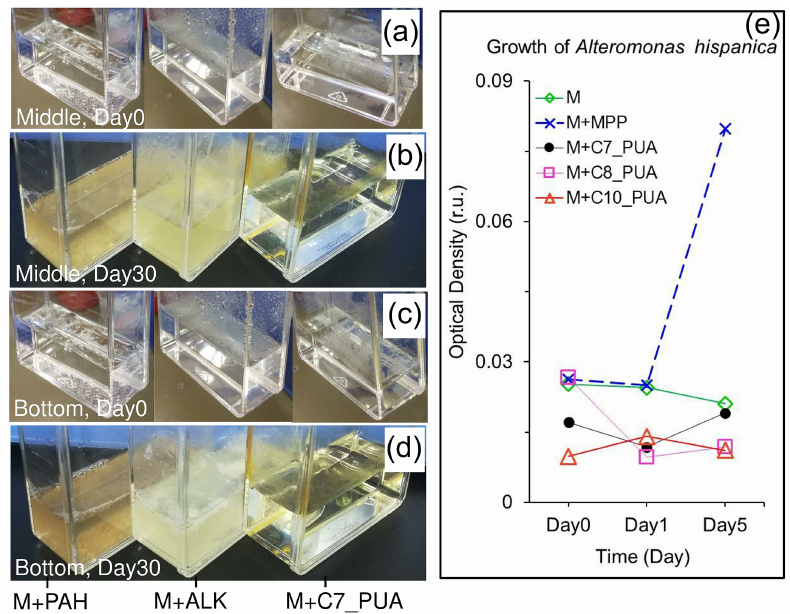
Figure 9. Carbon-source test of PUAs with cell culture of particle-attached bacteria inoculated from the low-oxygen waters of station Y1 including the initial conditions (day 0) at the beginning of the experiments as well as results after 30d of incubations (day 30) for (a, b) the middle and (c, d) the bottom waters, respectively. Bottles from left to right are the mediums (M) with the additions of polycyclic aromatic hydrocarbons (M + PAH, 200ppm), alkanes (M + ALK, 0.25gL − 1 ), and heptadienal (M + C7_PUA, 0.2mmolL − 1 ); note that a change in turbidity should indicate bacterial utilization of organic carbons. (e) The optical density of bacterium Alteromonas hispanica MOLA151 growing in the minimal medium as well as in the mediums with the additions of mannitol, pyruvate, and proline (M + MPP, 1% each), heptadienal (M + C7_PUA, 145µM), octadienal (M + C8_PUA, 130µM), and decadienal (M + C10_PUA, 106µM). The method